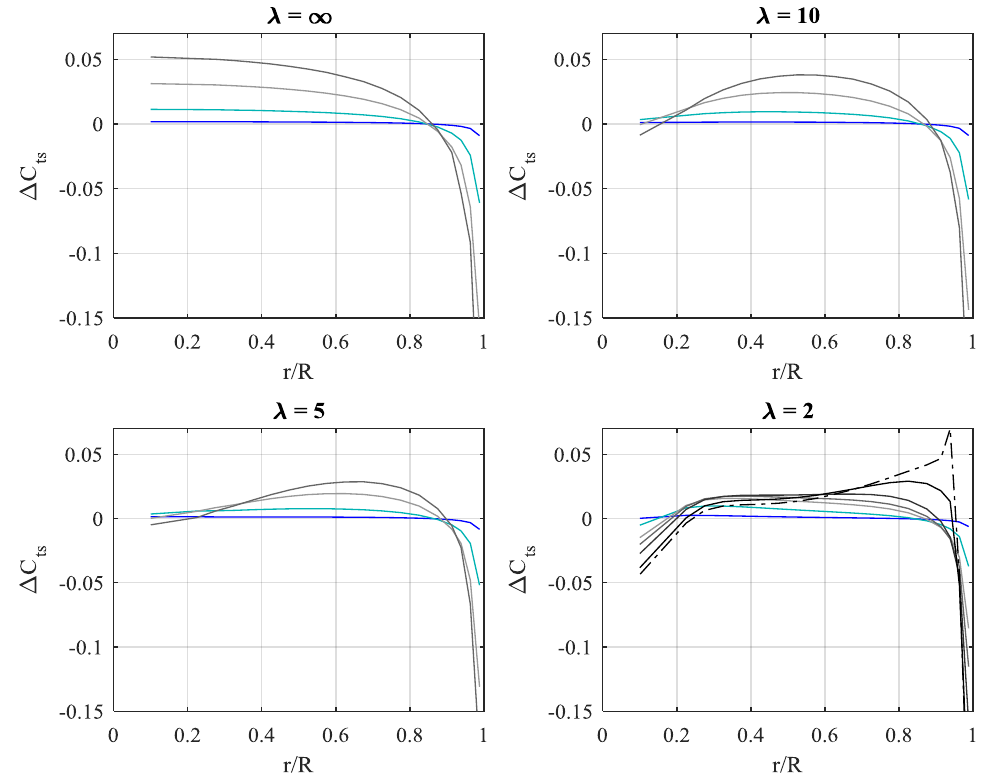
Figure 4. AD results: Radial distribution of annular element thrust coefficient ∆𝐶 𝑡𝑠 for different levels of rotor loading (color code, see Table 1) and tip-speed ratio 𝜆 .